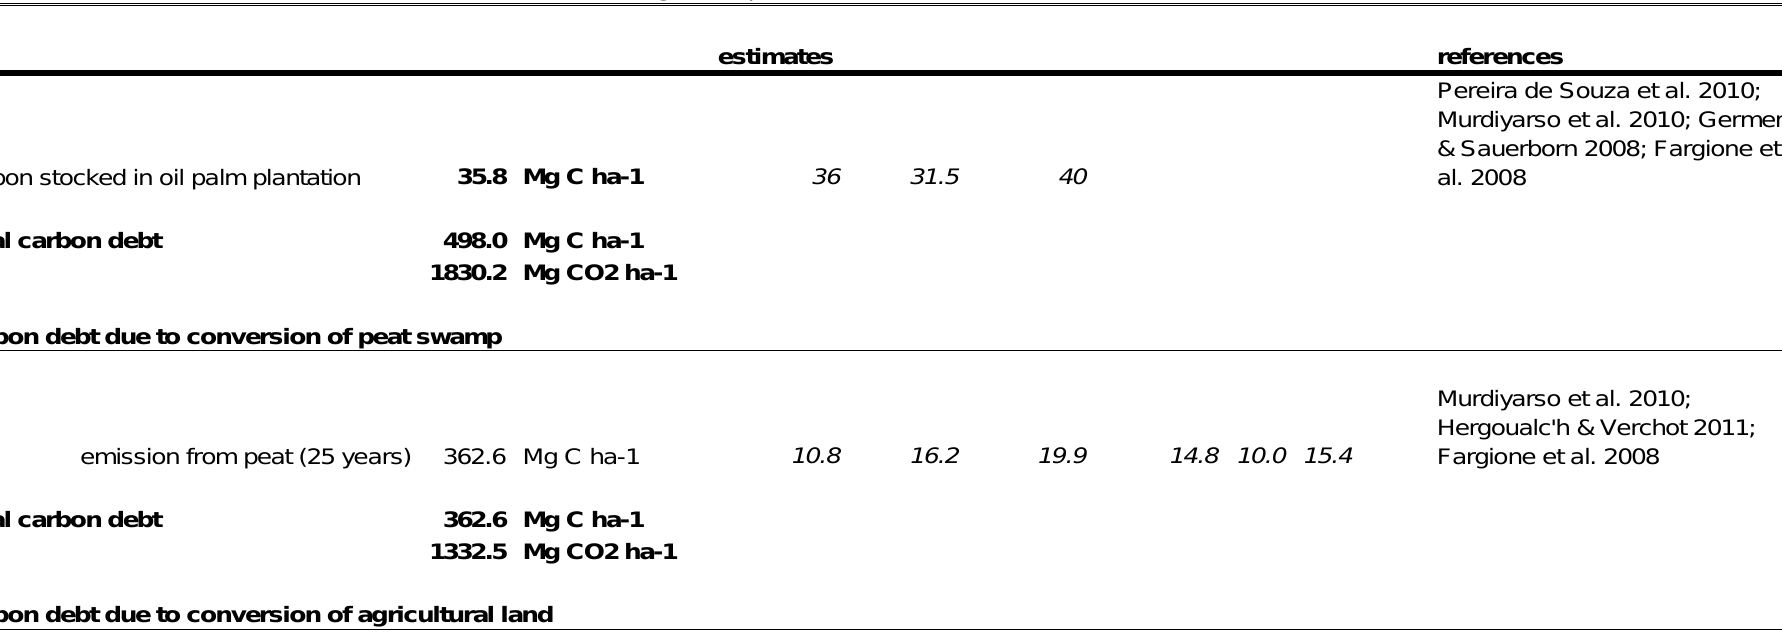
Table A2.3. continued Carbon debt calculation of the Boven Digoel, Papua, Indonesia